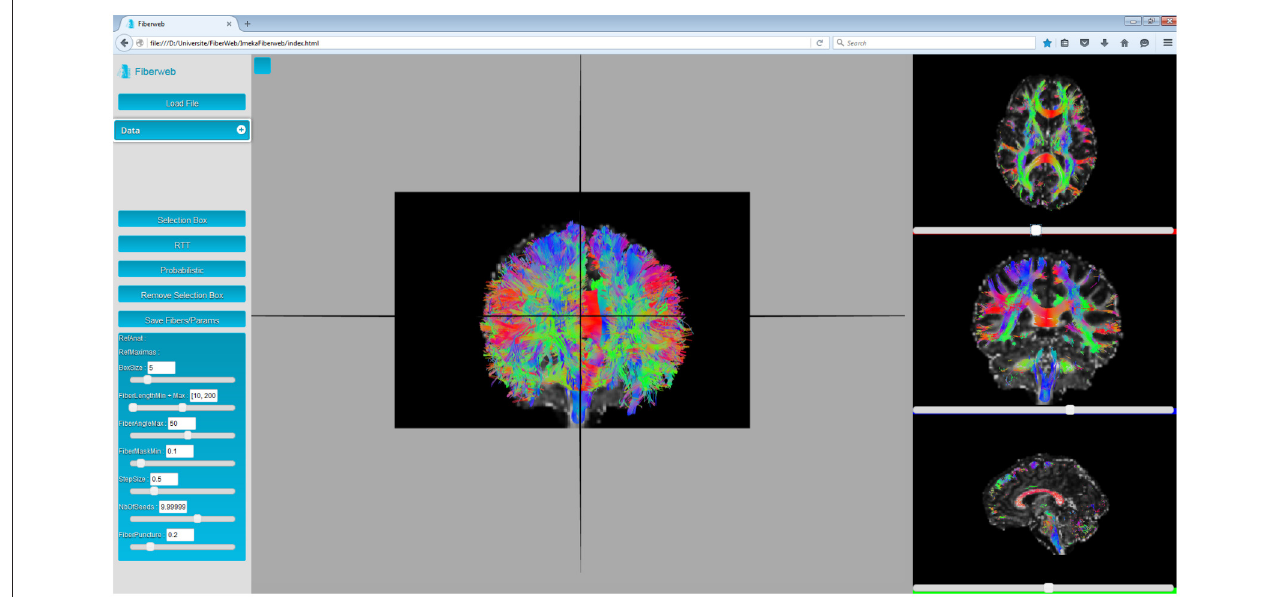
FIGURE 3 | Anatomy and streamlines visualization inside Fiberweb, with the intersected streamlines in the 2D views.